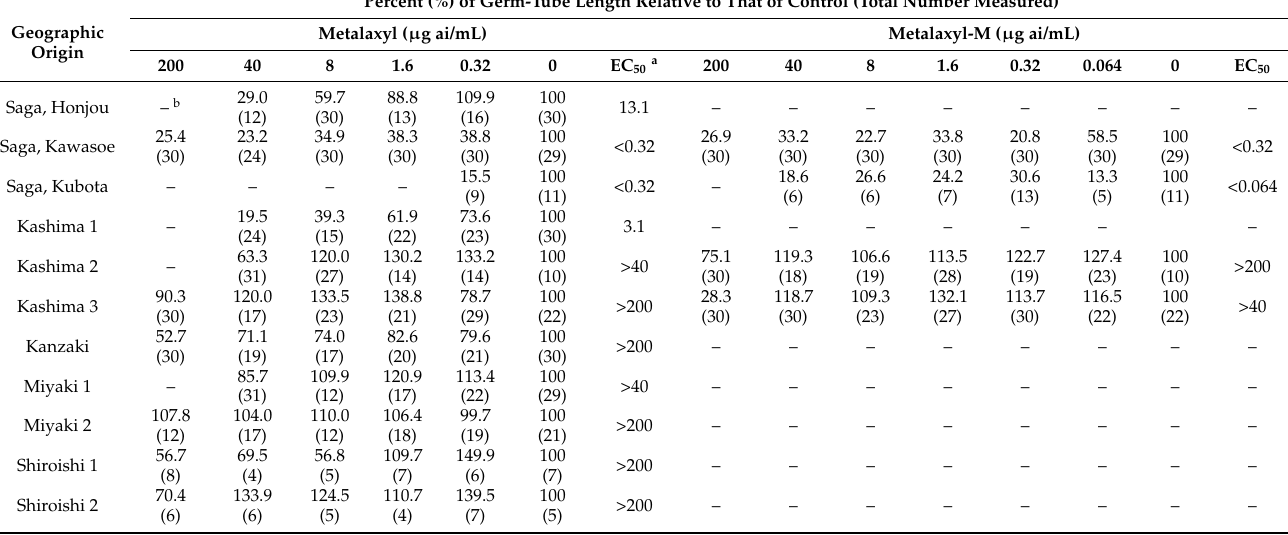
Table 6. Percentage of germ-tube length relative to that of control Peronospora destructor when grown in water amended with different metalaxyl and metalaxyl-M concentrations.